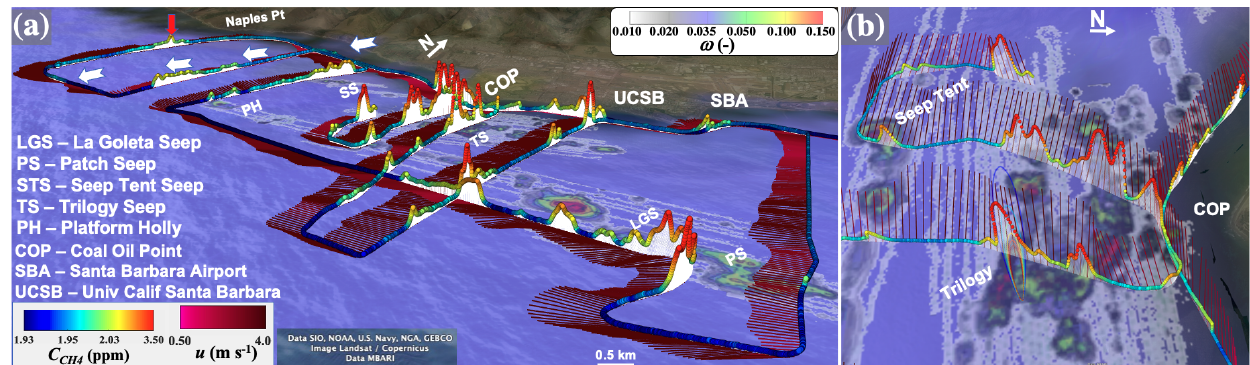
Figure 2. (a) Methane, C CH , and wind, u , data for 28 May 2016. White arrows show canyon offshore flow. Red arrows show unmapped 4 seepage to the west of the COP seep field. (b) C CH and u show the Gaussian plume model for Trilogy Seep. Sonar return map shown on 4 sea surface. Data key and seep name key in the panel. Displayed in © Google Earth. See Fig. S6 for overhead